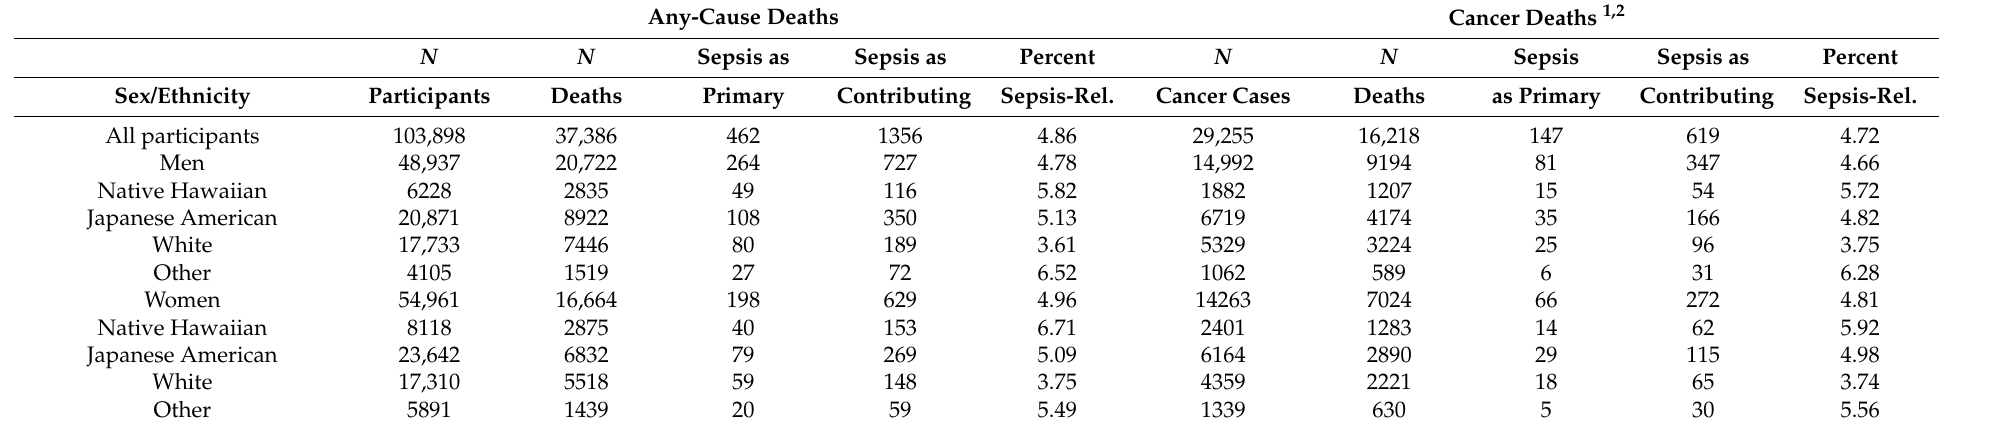
Table 2. Sepsis-related mortality among non-cancer and cancer patients in the Multiethnic Cohort. Any-Cause Deaths Cancer Deaths 1,2 Sepsis as